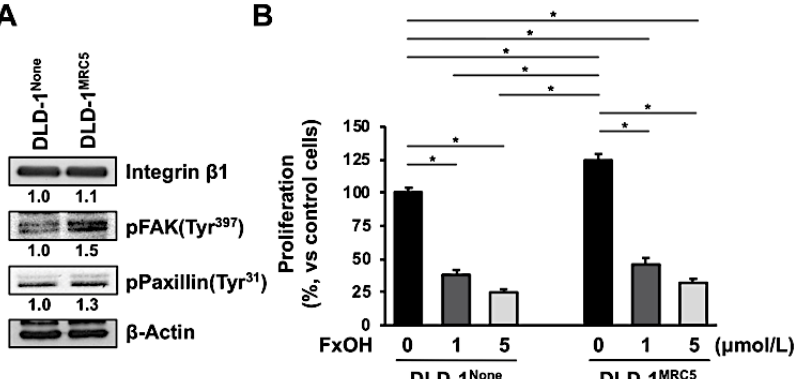
Figure 6. Antiproliferative effects of fucoxanthinol (FxOH) on DLD-1 None and DLD-1 MRC5 cells. DLD-1 None and DLD-1 MRC5 cells were treated with 1.0 or 5.0 μM FxOH for 2 d. ( A ) Untreated DLD-1 None and DLD-1 MRC5 cells were collected, and their protein levels were evaluated by western blotting. The value of each band was normalized to that of the β-actin band density from the image. ( B ) Cell viability was determined using a WST-1 assay. Values are the mean ± SE ( n = 3). Significant difference was performed by one-way ANOVA with a Tukey-Kramer post-hoc test. * p < 0.05.